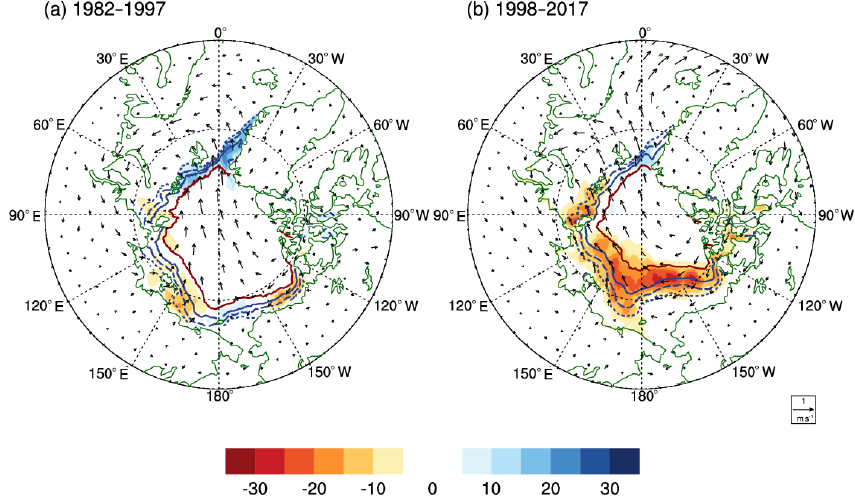
Figure 6. Regression patterns of sea ice concentration (shaded, %) and the surface wind anomalies (vector, m s − 1 ) onto the AD index for (a) the early (1982–1997) and (b) the recent (1998–2017) period. The AD index was reversed in sign for the melting phase of sea ice. Colored lines indicate the time-mean sea ice concentration of 15% (red dotted), 30% (red dashed), 50% (red solid), and 80% (blue solid) in each